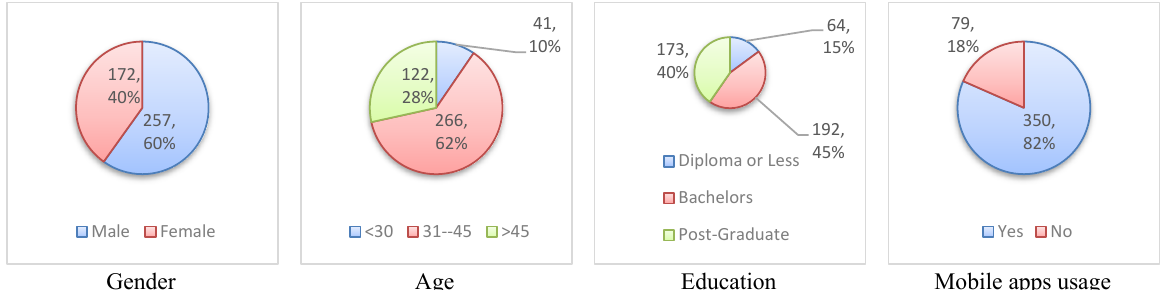
Fig. 2. Personal characteristics of the participants